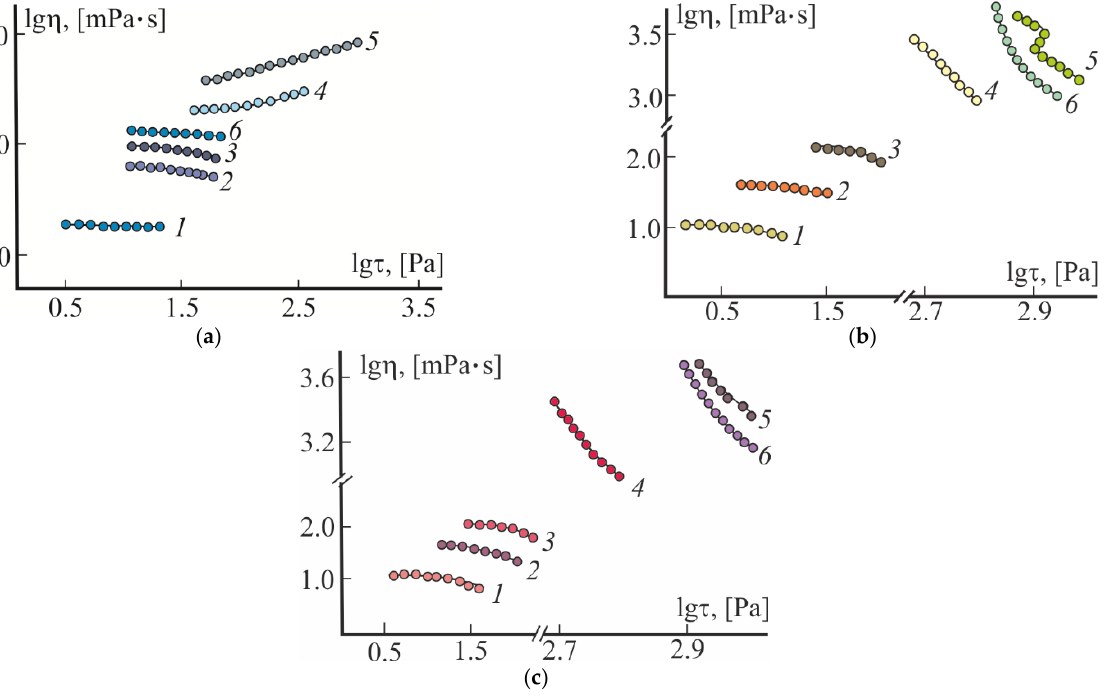
Figure 2. Viscosity curves of aqueous CS·HCl solutions with С CS·HCl = 3 wt.% ( 1 ), Pl F-127 with С Pl F-127 = 25 wt.% ( 5 ) and CS·HCl : Pl F-127 mixtures in volume ratios (vol./vol.): 70:30 ( 2 ), 50:50 ( 3 ) and 30:70 ( 4 , 6 ) without ( 2 – 4 ) and with an additive of 3 wt.% D-AscA ( 6 ) at 4 ( a ), 25 ( b ) and 37 °C ( c ).